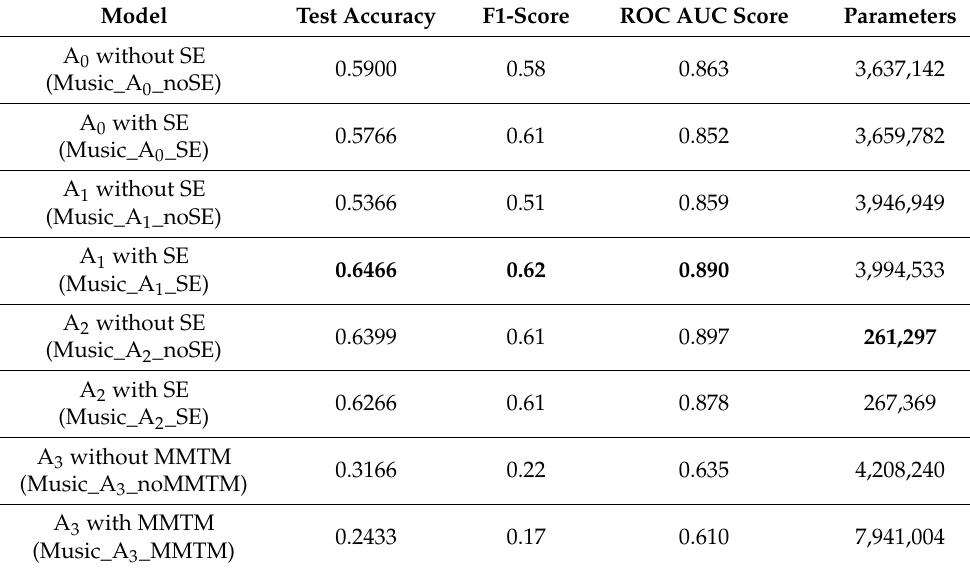
Table 3. Test results using music information.